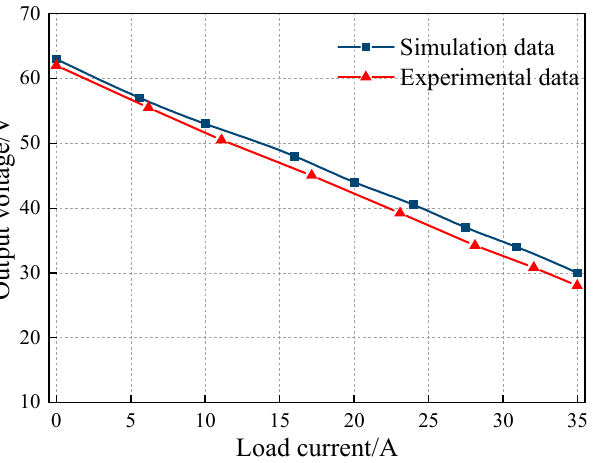
Figure 25. Induced EMF of the compound excitation generator prototype under different loads. ( a ) Load 10 Ω ; ( b ) Load 5 Ω ; ( c ) Load 3 Ω ; ( d ) Load 1.5 Ω .